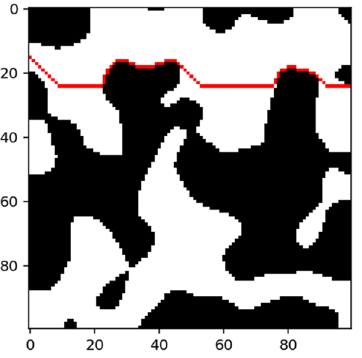
Figure 9. The red line represents a geometric path for tortuosity